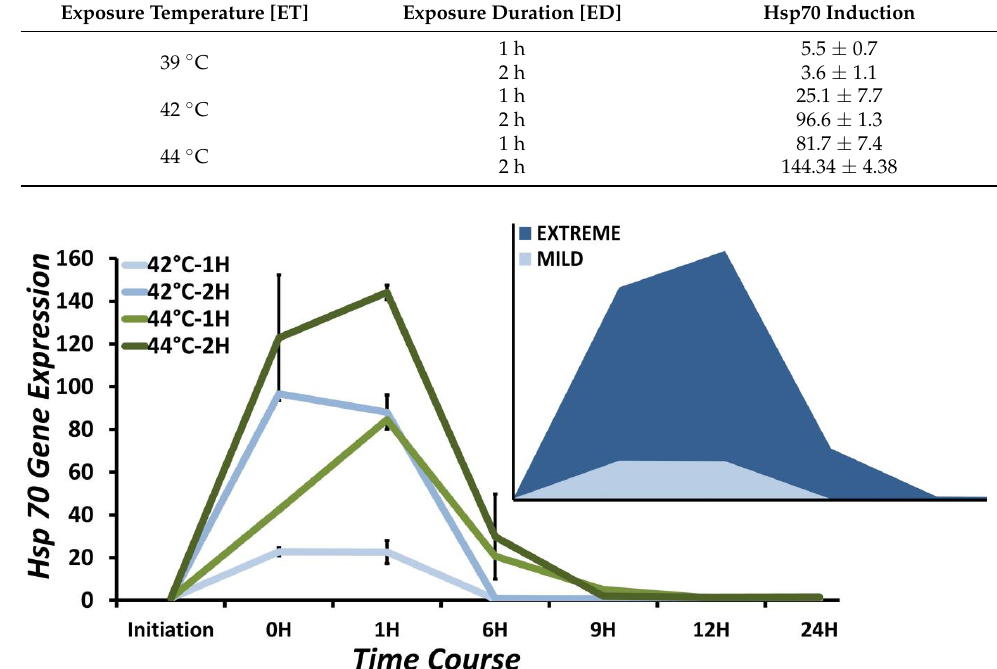
Figure 2. Dose-responsive nature of heat stress in SH-SY5Y cells. Time-course analysis of Hsp70 gene expression induction at 42 and 44 °C for 1 and 2 h. Initiation represents the time point when cells are transferred to heat-stress conditions. 0 h represents the start point of the recovery at 37 °C. As the magnitude of heat stress increases, the heat shock response proportionately goes up. The temperature has a slightly different impact on expression baseline attainment at 9 h at 44 °C versus (green) at 6 h at 42 °C (blue). Inset: Graphic representations of the extreme and mild heat stress models. (see Figure S3 for a detailed time course including the response at ET: 44 °C and ED: 1 and 2 h).